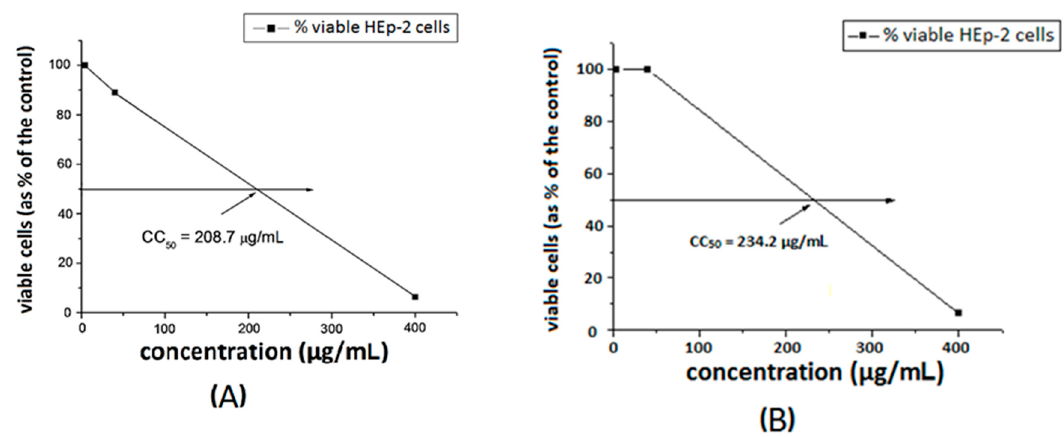
Figure 8. Cytotoxic concentration at 50% of ligand S2 ( A ) and [Cu 8 (S2)] ( B ) in HEp-2 cell culture.